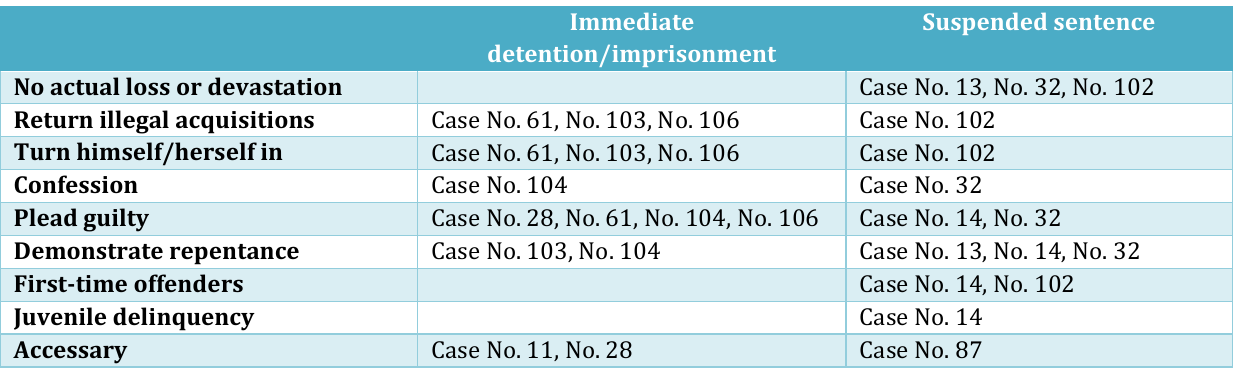
Table 5: Extenuating circumstances for individuals sentenced to criminal detention or imprisonment of no more than three years under the Guiding Cases